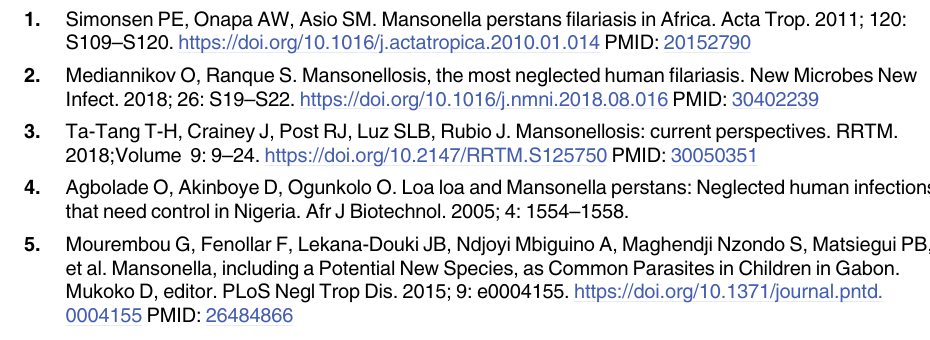
S6 Table. Individual reaction results of field-collected mosquito sample testing. Cq values resulting from the testing of all mosquito samples are provided for both reference and index